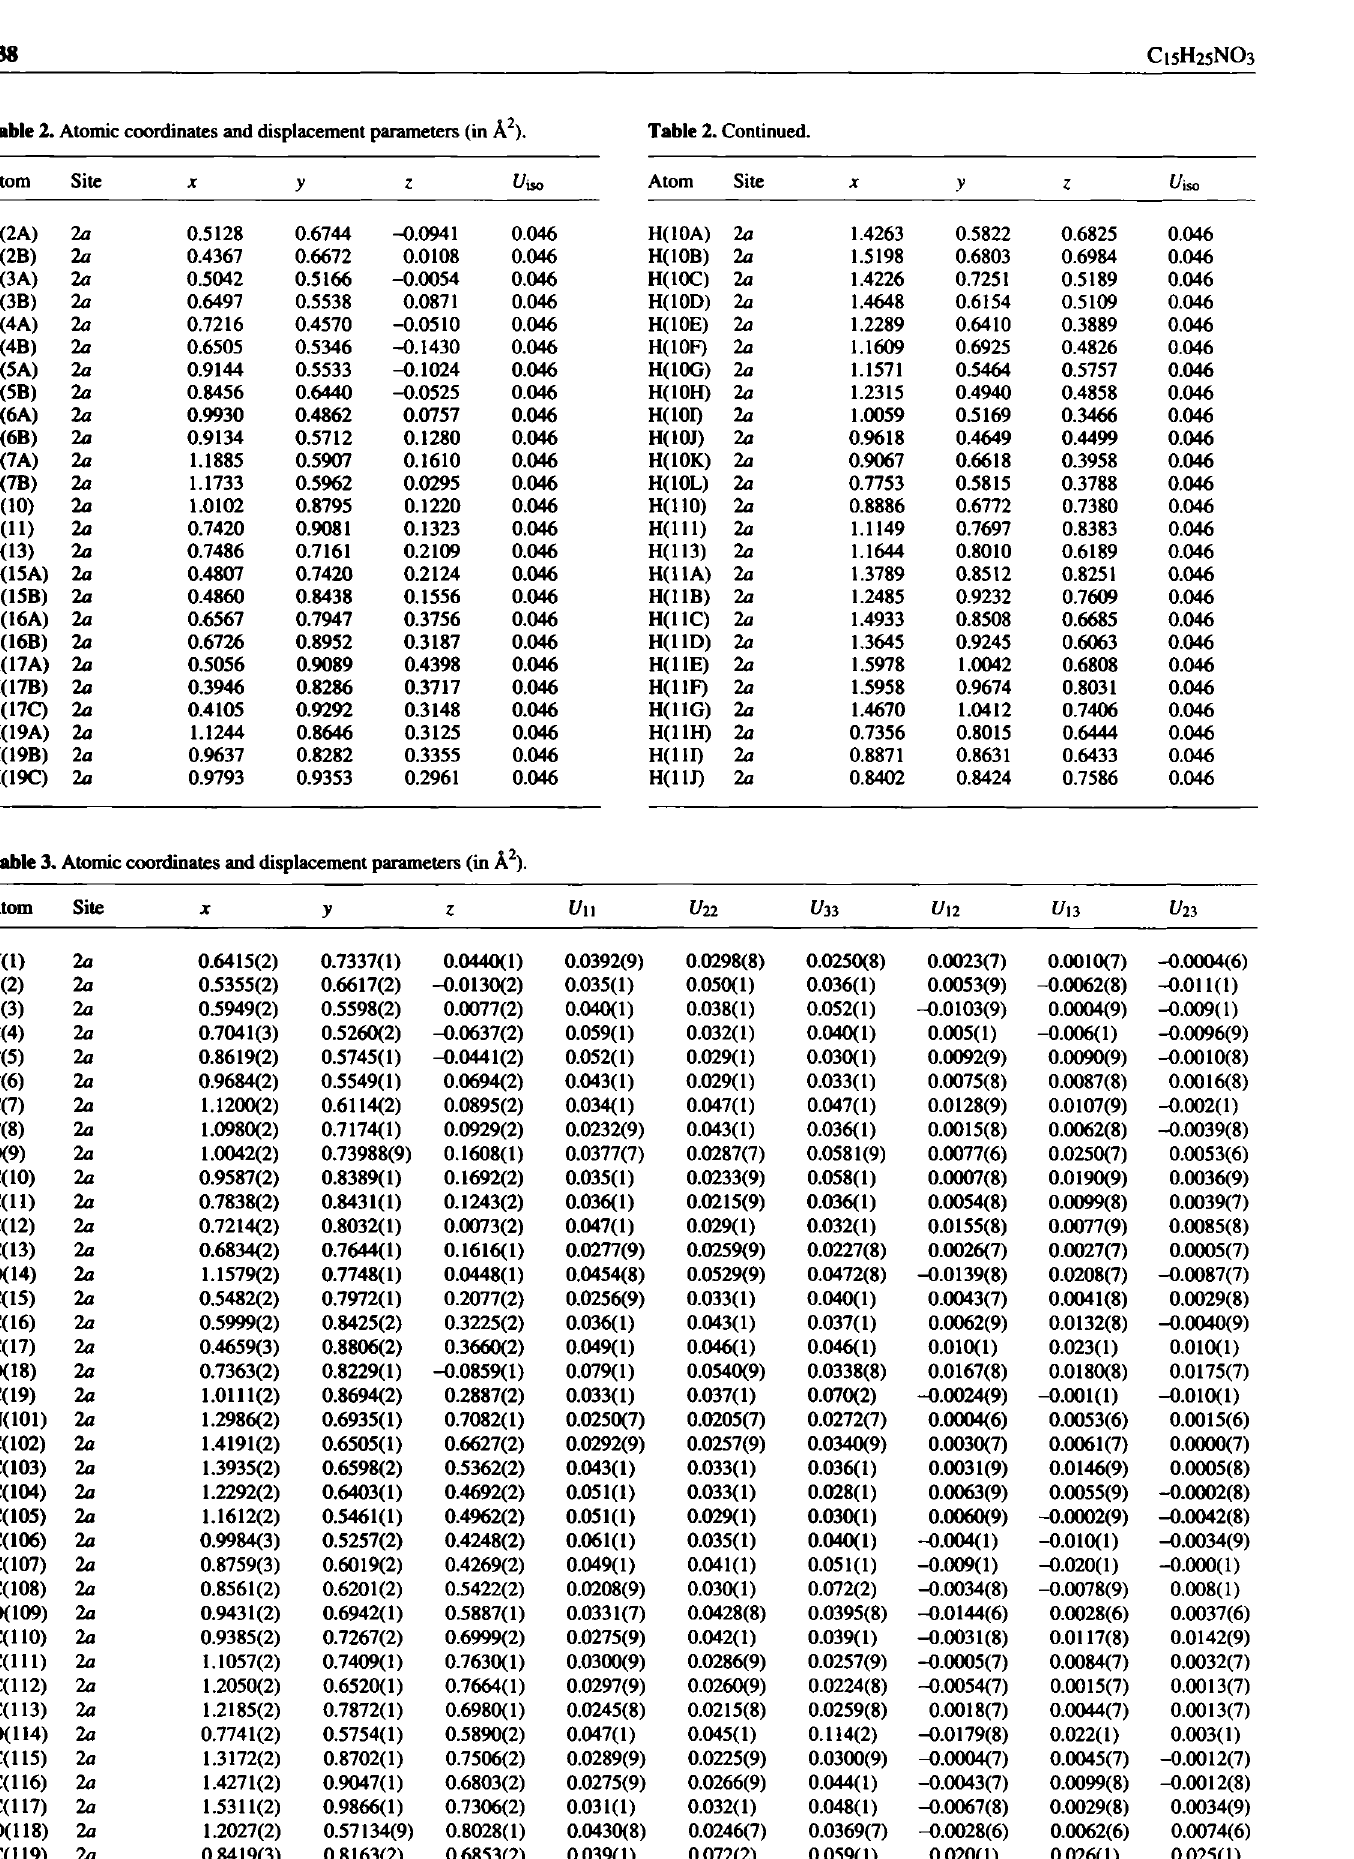
Table 2. Atomic coordinates and displacement parameters (in Â 2 ).